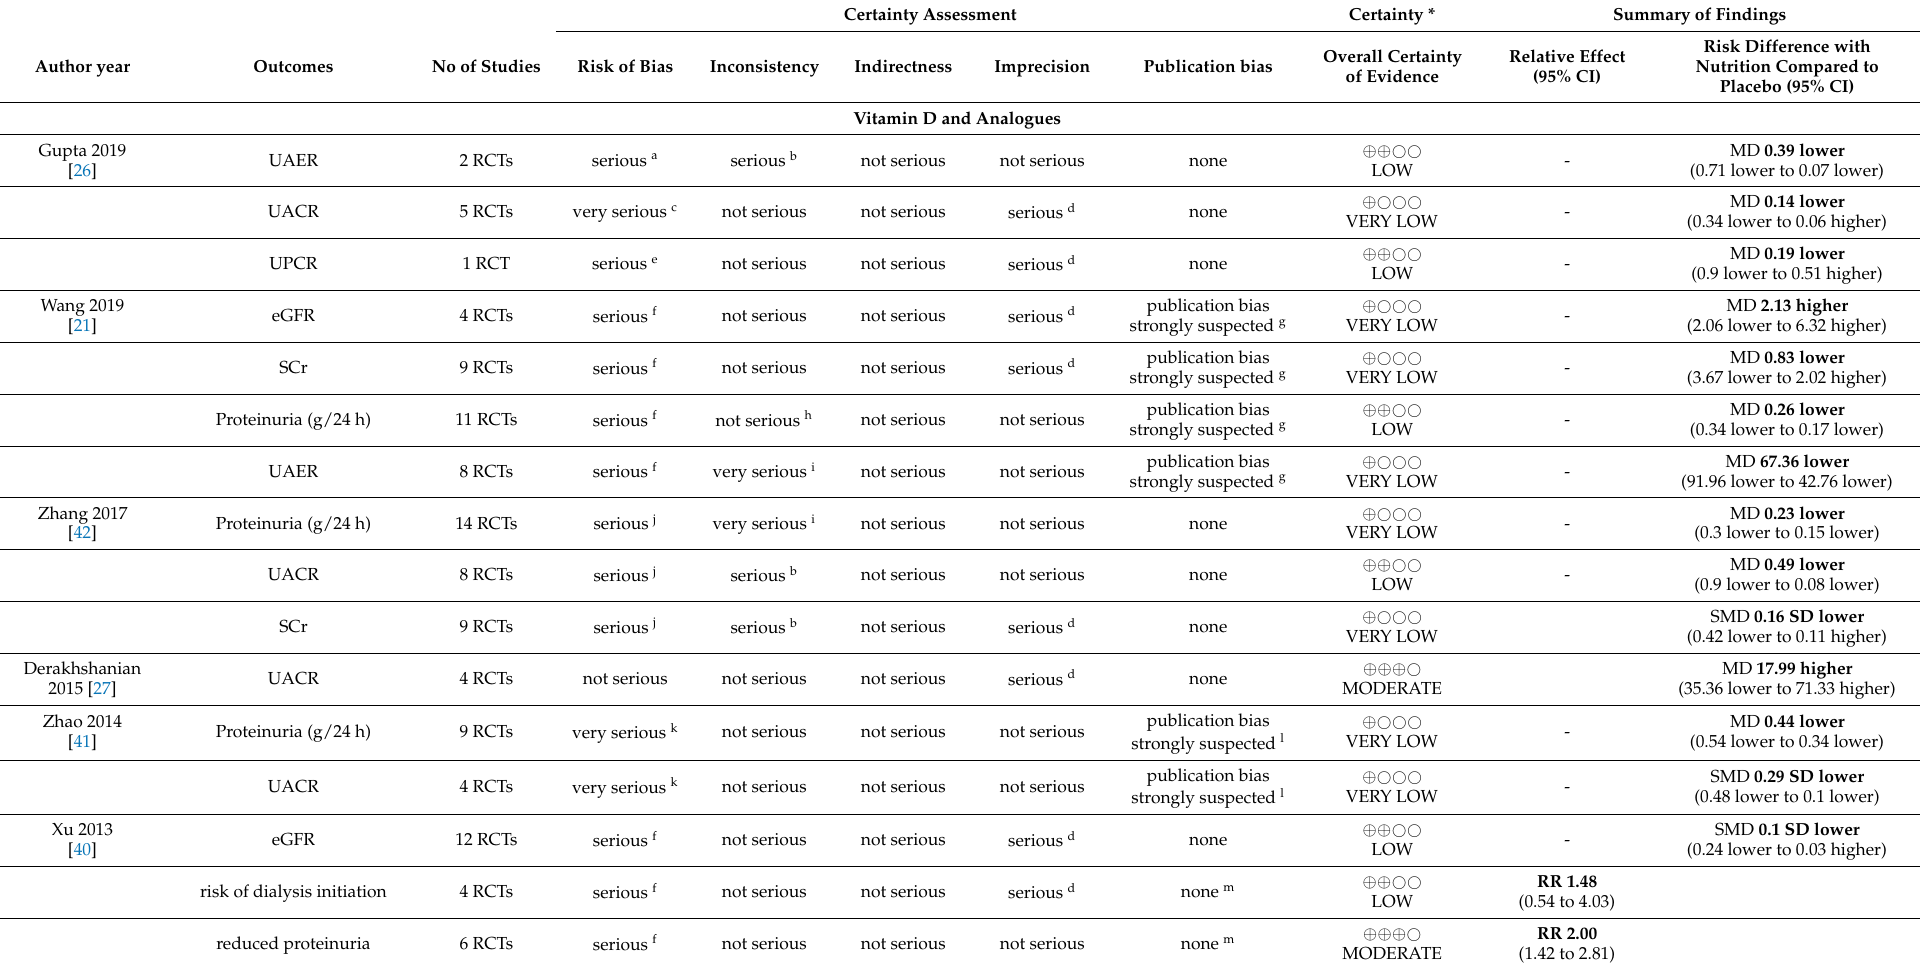
Table 2. Grading of Recommendations Assessment, Development, and Evaluation (GRADE) approach evidence certainty and summary of findings of the clinical important